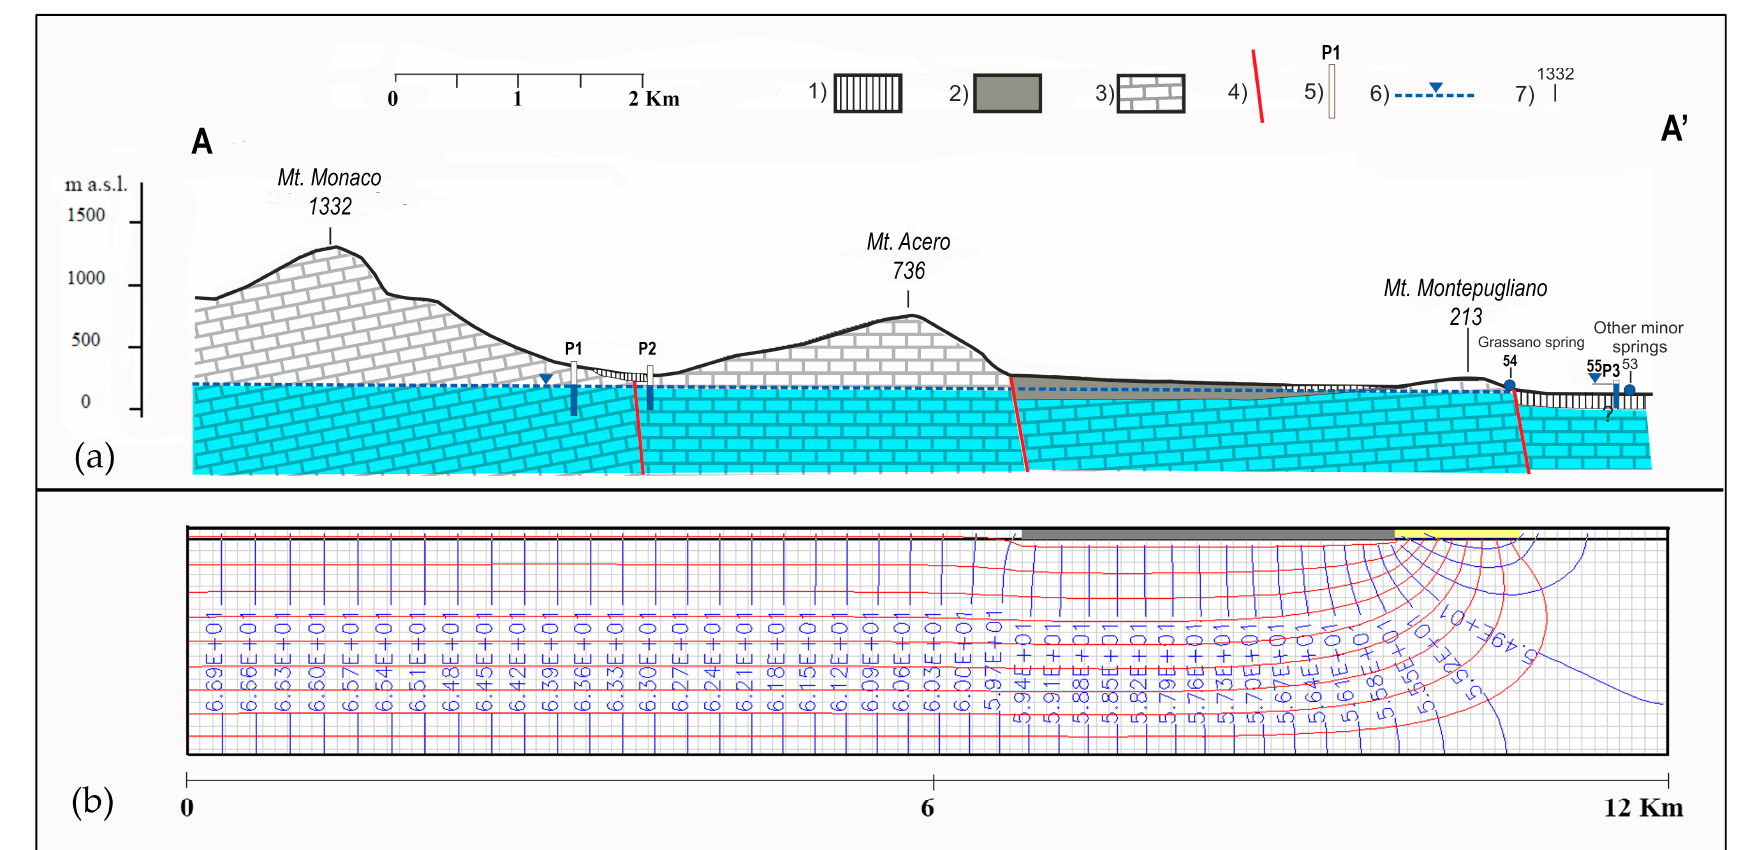
Figure 9. ( a ) Hydrogeological cross-section (trace AA ′ in Figure 4). The water table has been drawn by piezometers P1 and P2. Artesian conditions are detected in the Telese plain by borehole P3. 1) Aquitard (alluvial, pyroclastic, and travertine complex); 2) aquiclude (flysch sequences); 3) karst aquifer (carbonate sequences); 4) fault; 5) borehole; 6) hydraulic head; 7) elevation point. ( b ) MODFLOW numerical code simulation along the cross-section AA ′ . Flow net highlights the upwelling phenomenon in correspondence with the Montepugliano relief; numbers show the hydraulic head of each equipotential line (m a.s.l.).